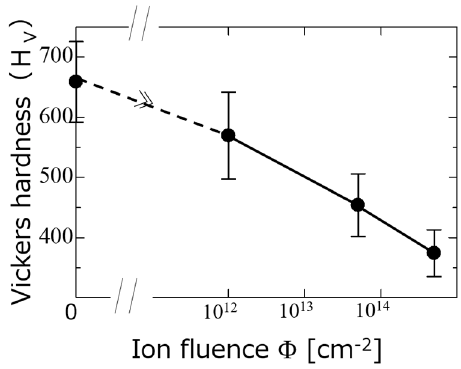
Figure 19. Vickers hardness for Ni 3 V as a function of 16MeV Au ion fluence.